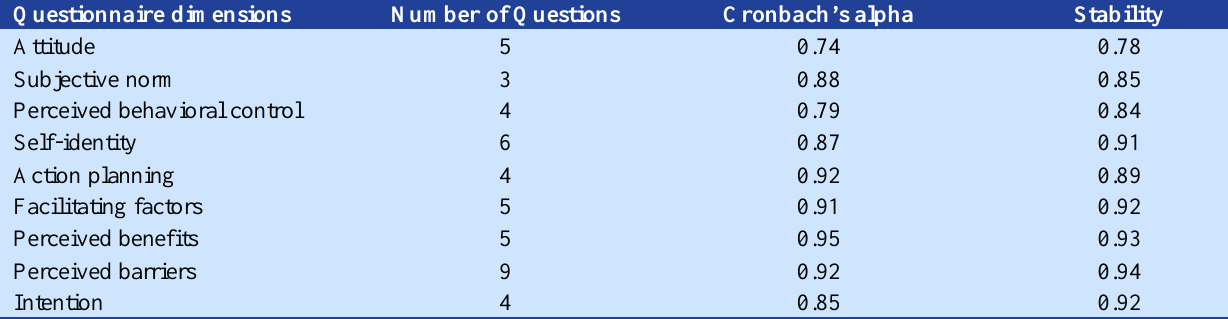
Table 4. The reliability results of the questionnaire subscales in theory of planned behavior (TPB) based study Questionnaire